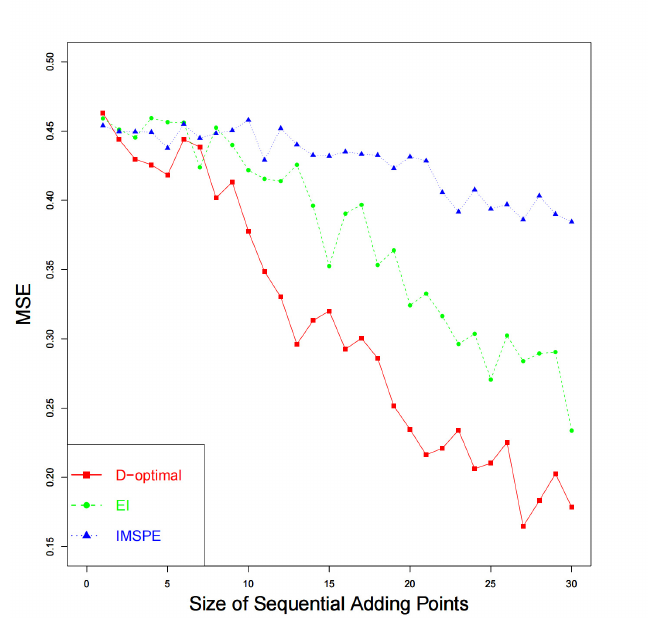
Figure 1. MSE l of θ obtained using the proposed sequential D-optimal method, EI method, and IM- SPE method by sequentially adding computer experiment